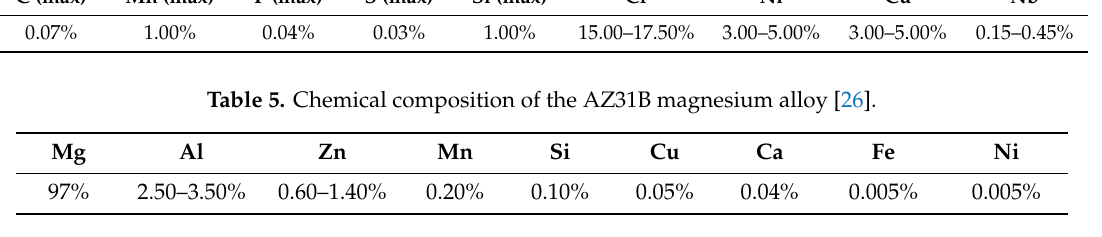
Table 6. Chemical composition of the AA 7075-T7351 aluminum alloy